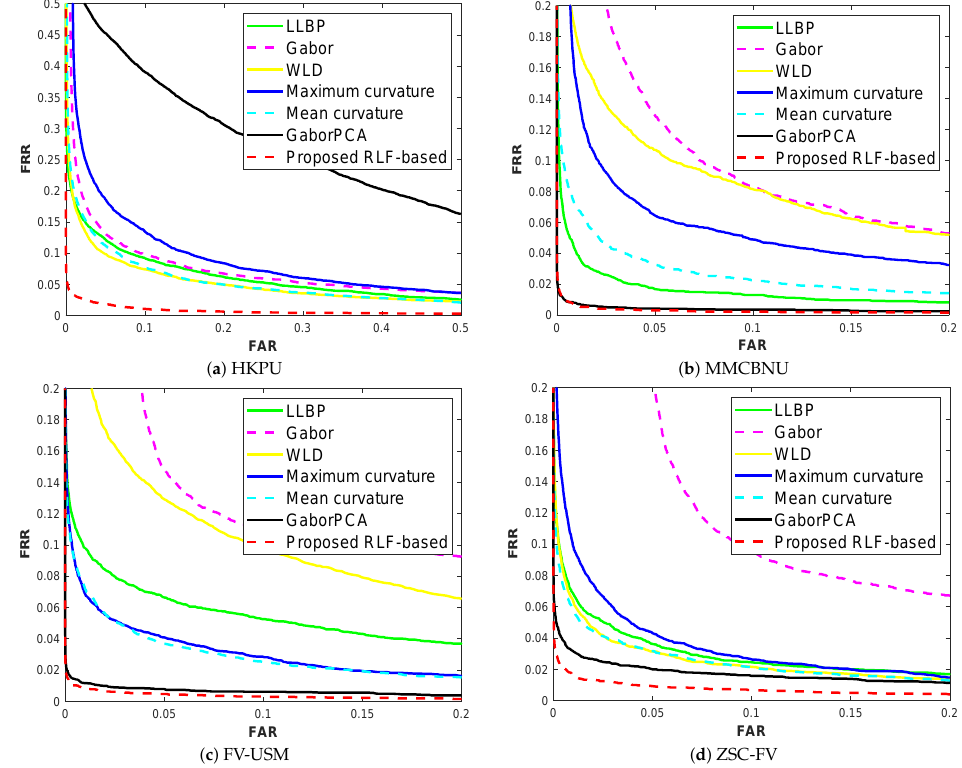
Figure 10. False acceptance rate (FAR)-false rejection rate (FRR) curves of compared methods on four finger vein databases, the margin parameters are c w = 30, c h =